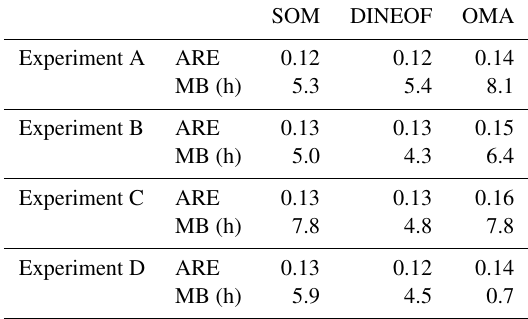
Table 4. Mean absolute relative error (ARE) and mean bias (MB) of the RT obtained using reconstructed HFR velocities from the three methodologies with respect to the REF-RT for all the experiments. A total of 156240 RT values are used in the computations.